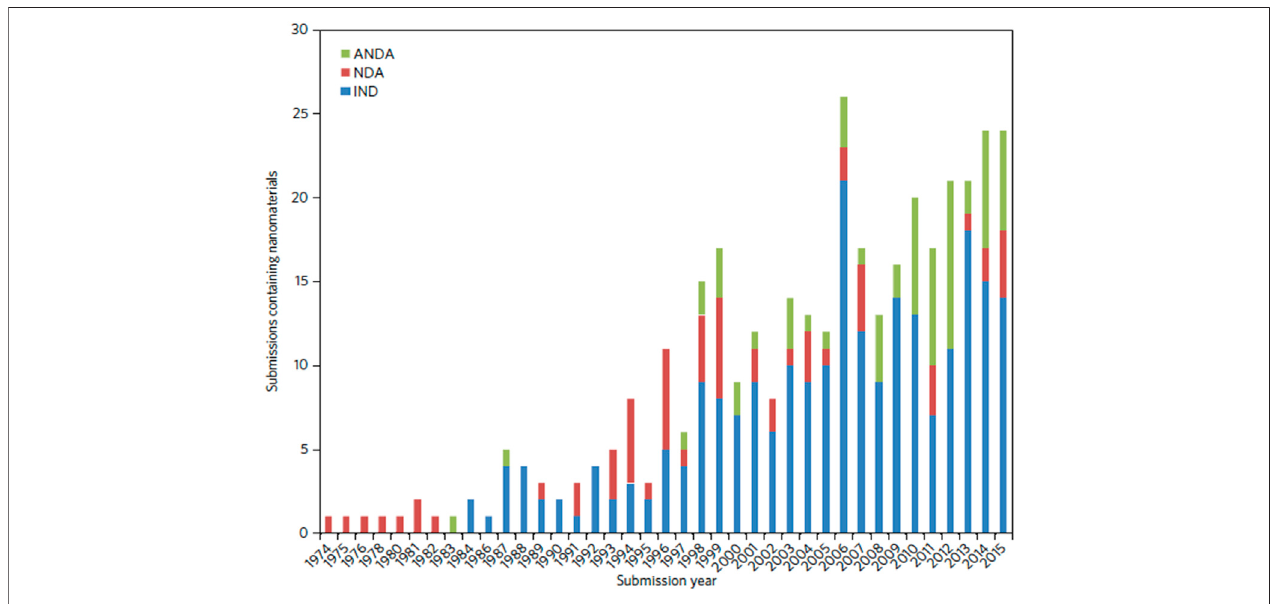
FIGURE 1 | Number of nanomaterial product applications submitted to CDER by year. Applications are separated as INDs, NDAs, and ANDAs.